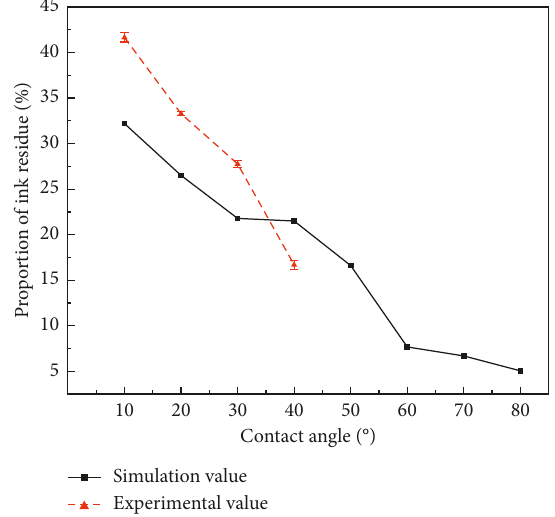
Figure 19: Influence of different contact angles on the proportion of ink